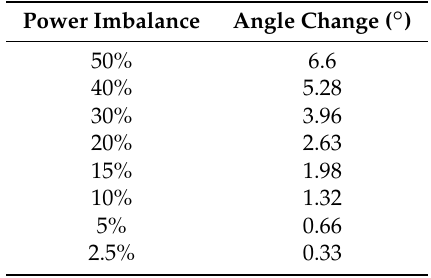
Table 1. Angle change vs. active power